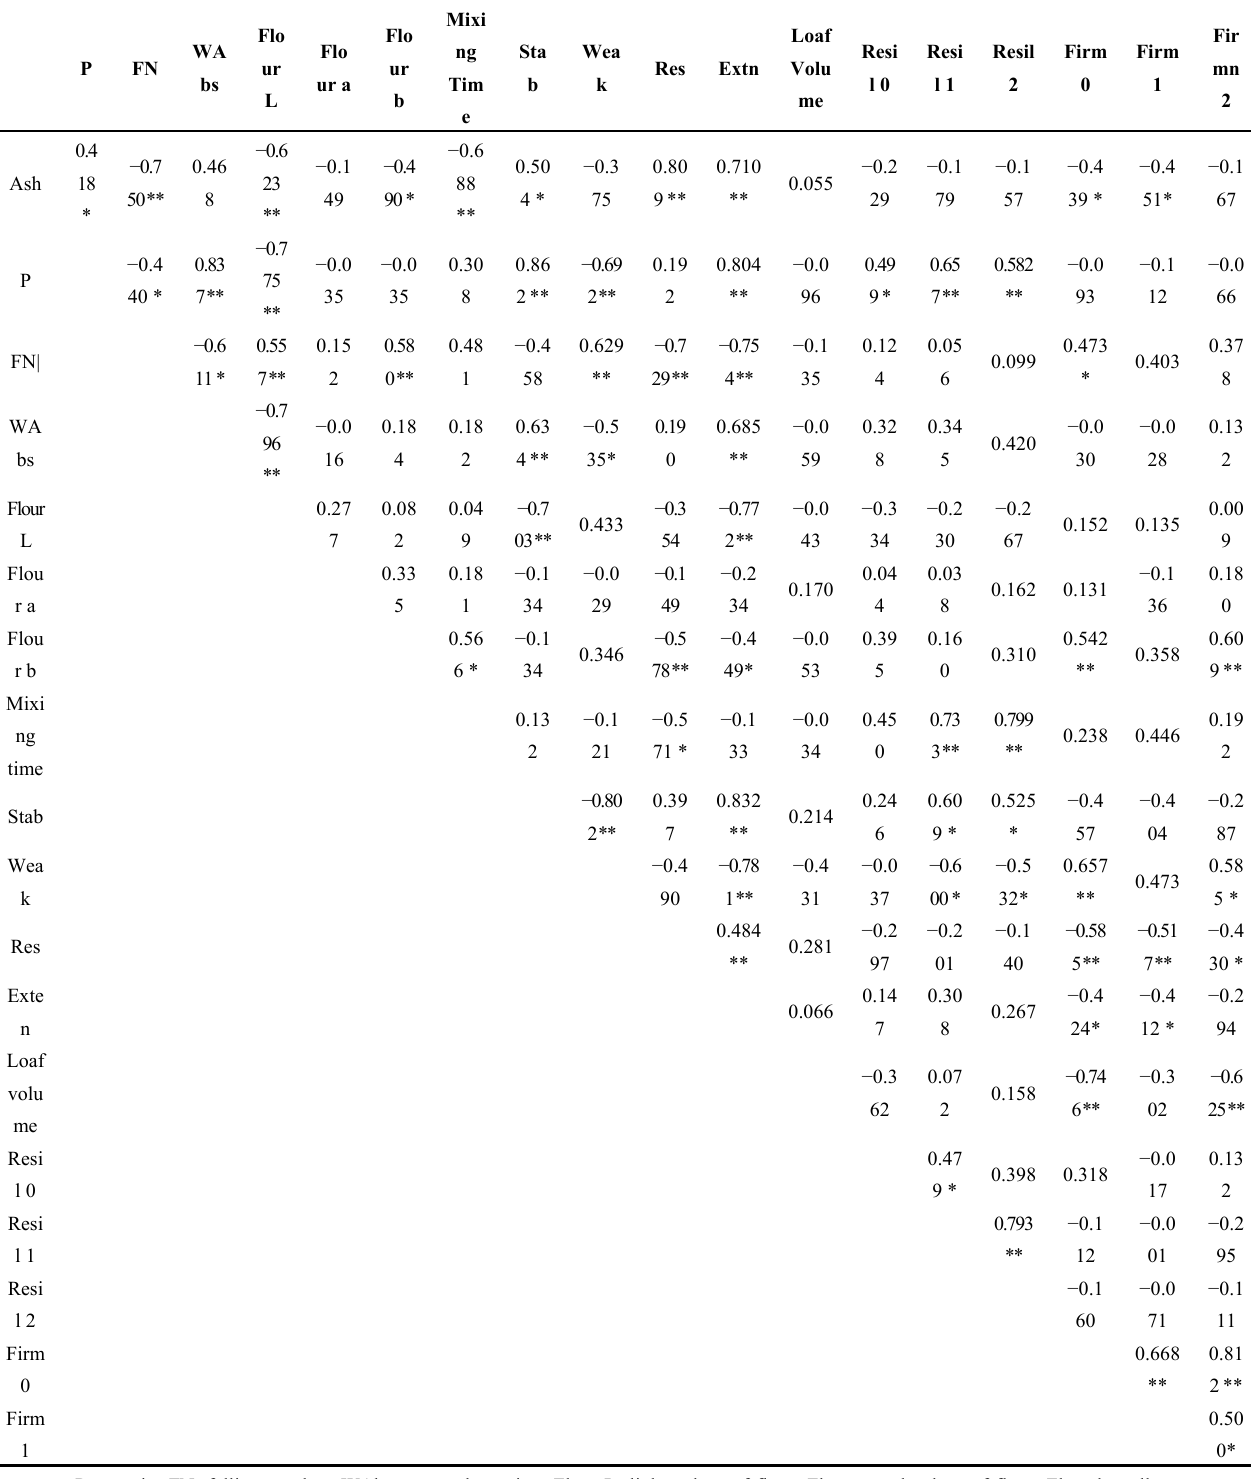
Table 6. Correlation coefficients between characteristics of all